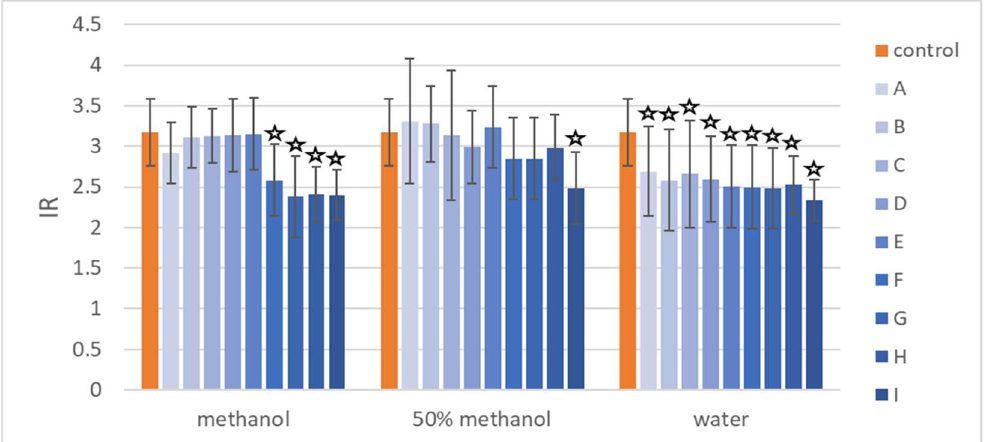
Figure 9. The results of the evaluation of anti-photogenotoxic activity based on IR values for the control—photogenotoxin chlorpromazine (CPZ 5 µg/mL)—and the mixture of CPZ with extracts (100 µg/mL) dissolved in methanol, 50% methanol, or deionized water. The asterisks highlights the statistically significant ( p < 0.05) differences in the cells’ viability compared with the control. The extracts from the following treatments were investigated: ( A ) control roots collected after 10 days of culture; ( B ) control roots collected after 20 days of culture; ( C ) control roots collected after 30 days of culture; ( D ) control roots collected after 40 days of culture; ( E ) control roots collected after 50 days of culture; ( F ) hairy roots elicited for 3 days with 50 µM MeJA; ( G ) hairy roots elicited for 7 days with 100 µM MeJA; ( H ) hairy roots elicited for 1 day with 100 µM MeJA 100 and then transferred to control medium for 30 day cultivation; ( I ) hairy roots elicited for 7 days with 100 µM MeJA 100 and then transferred to control medium for 30 day cultivation.